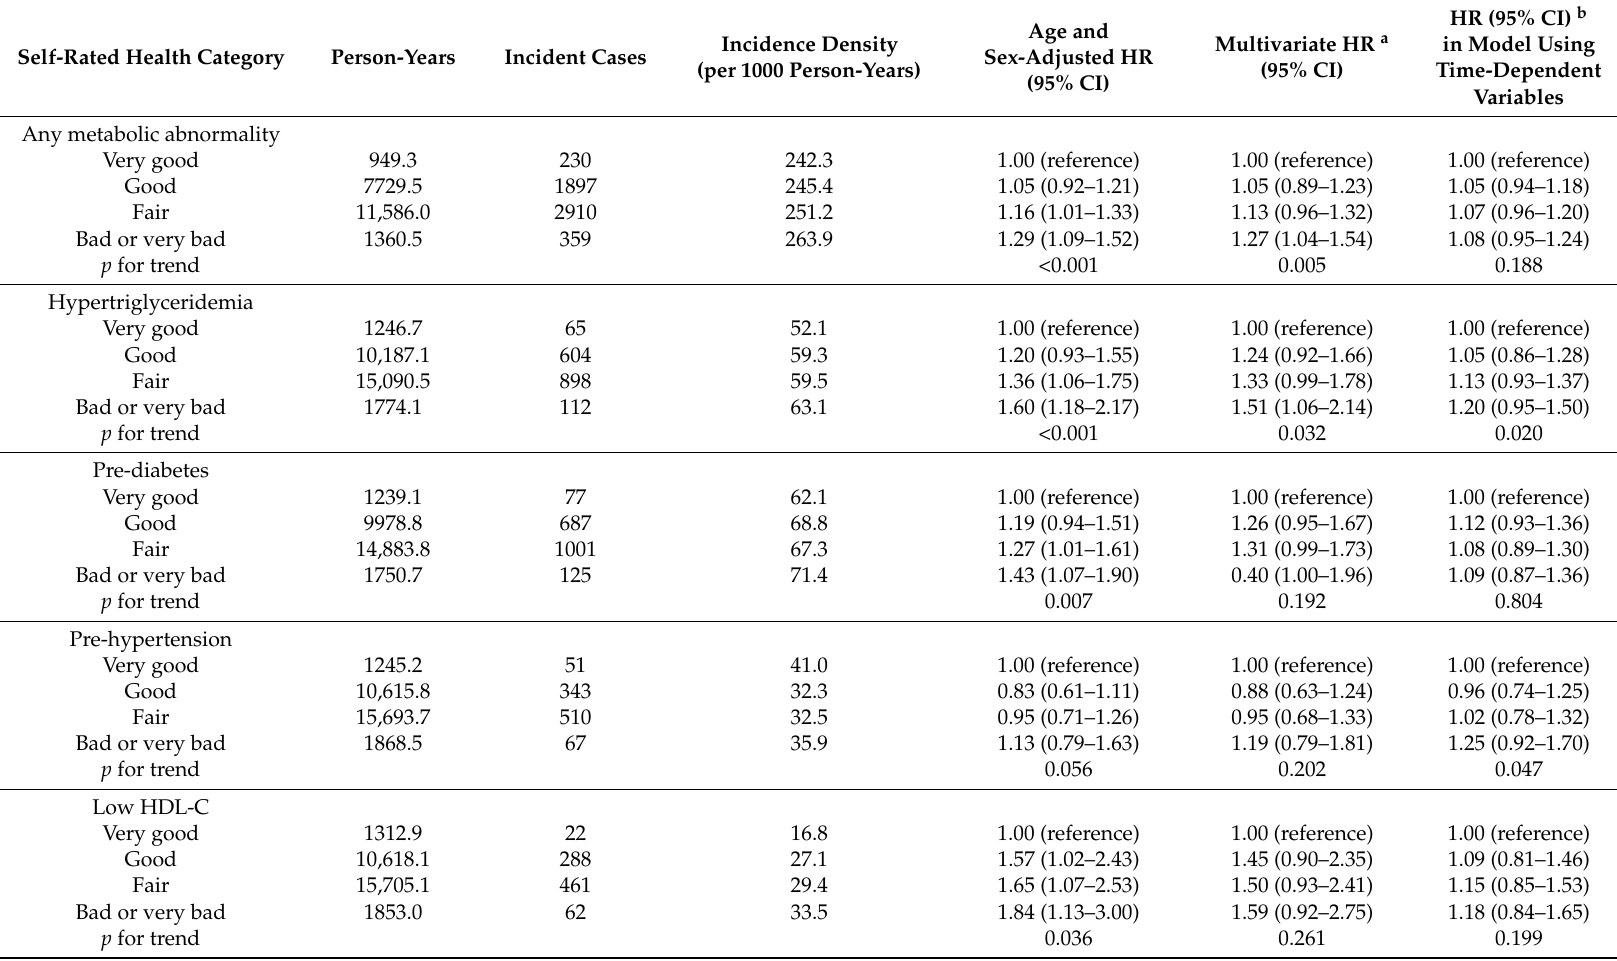
Table 3. Development of each metabolic abnormality by self-rated health category among metabolic healthy obese